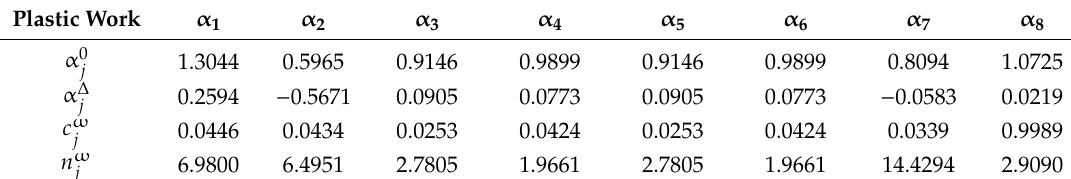
Table 9. Evolution coefficients for the parameters of the yield function of the niobium sheet. Plastic Work